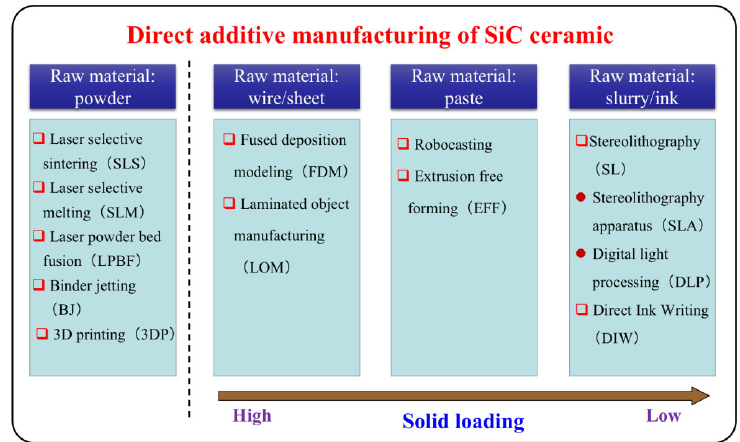
Fig. 8 Different direct AM technologies of SiC ceramic based on the state of the used raw materials.